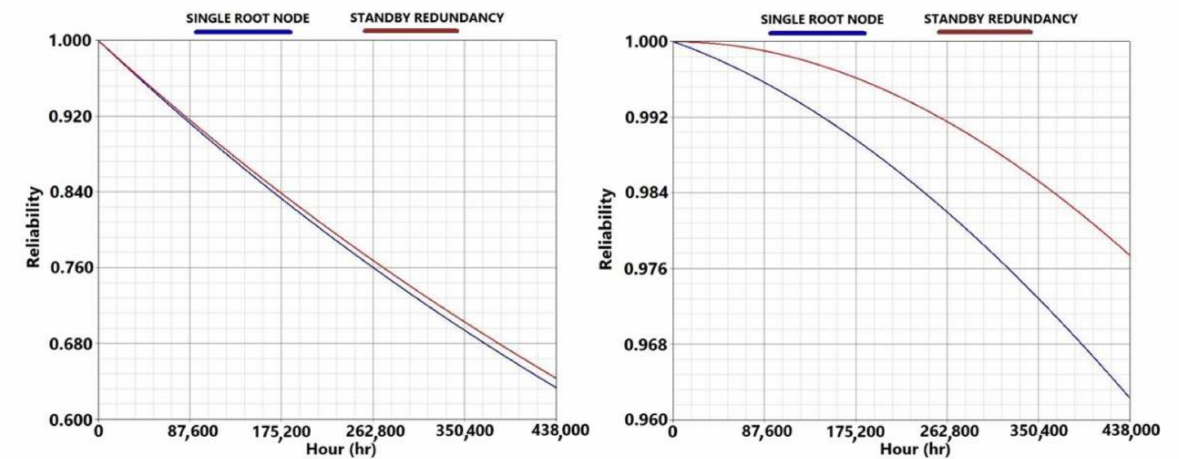
Figure 8. Reliability trends of the network under test obtained using the Reliability Block Diagram method for the series architecture on the left side and for the hybrid architecture on the right side. The blue lines stand for the reliability without standby redundancy, while the red lines represent the reliability considering the standby redundancy of the root